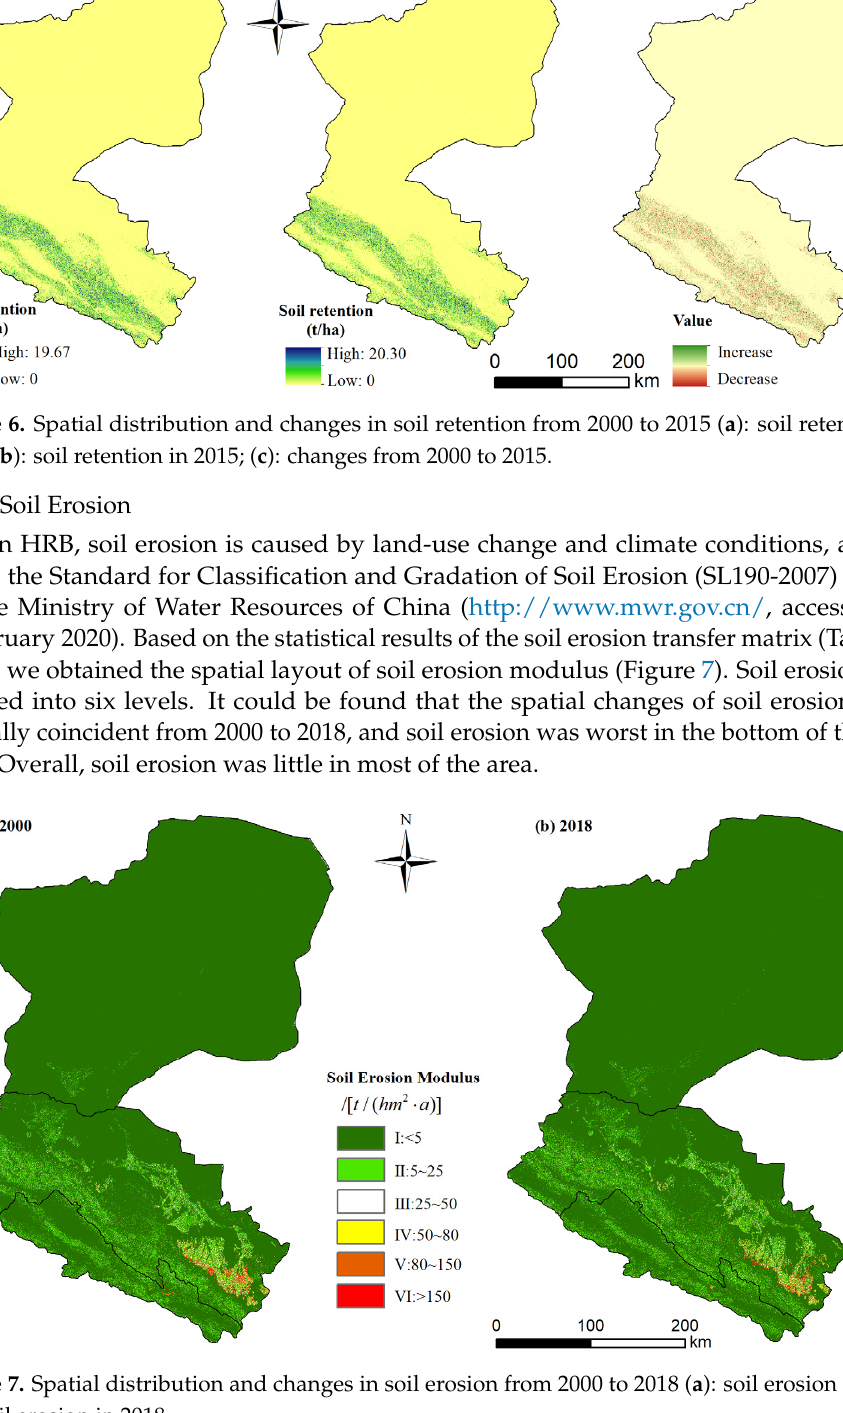
Table 4. The percentage of soil erosion level in the Heihe River Basin from 2000 to 2018. (unit: %). Erosion